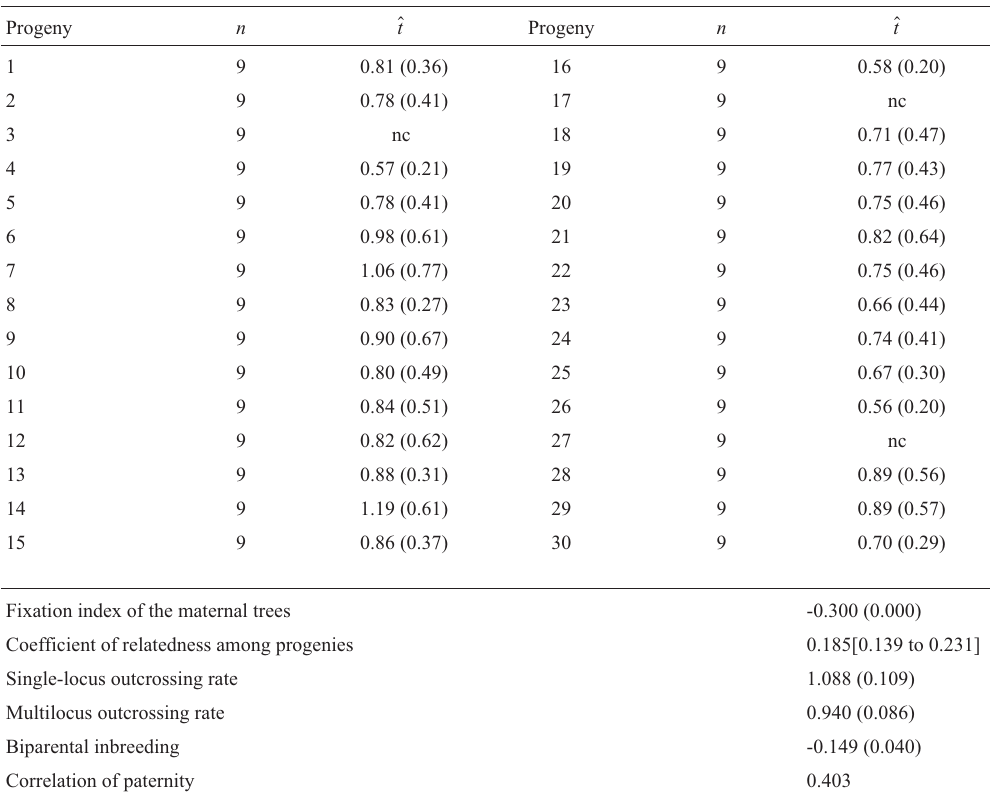
Table 2 - Estimate of the individual multilocus outcrossing rate ( $ t ) and mating system parameters of an M. urundeuva population . Progeny